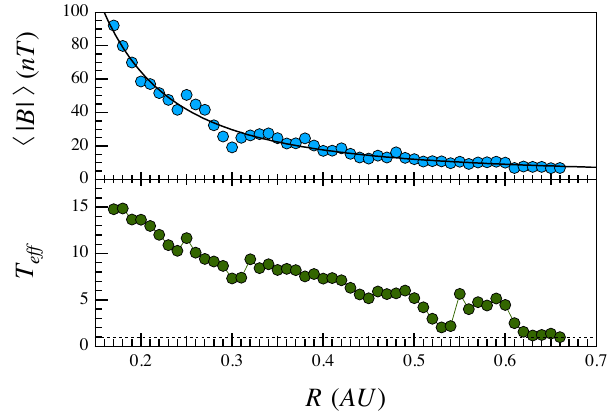
Figure 10. The trend behavior of the effective temperature T ef f (bottom panel) in comparison with the average magnetic field intensity (cid:104)| B |(cid:105) (up panel).